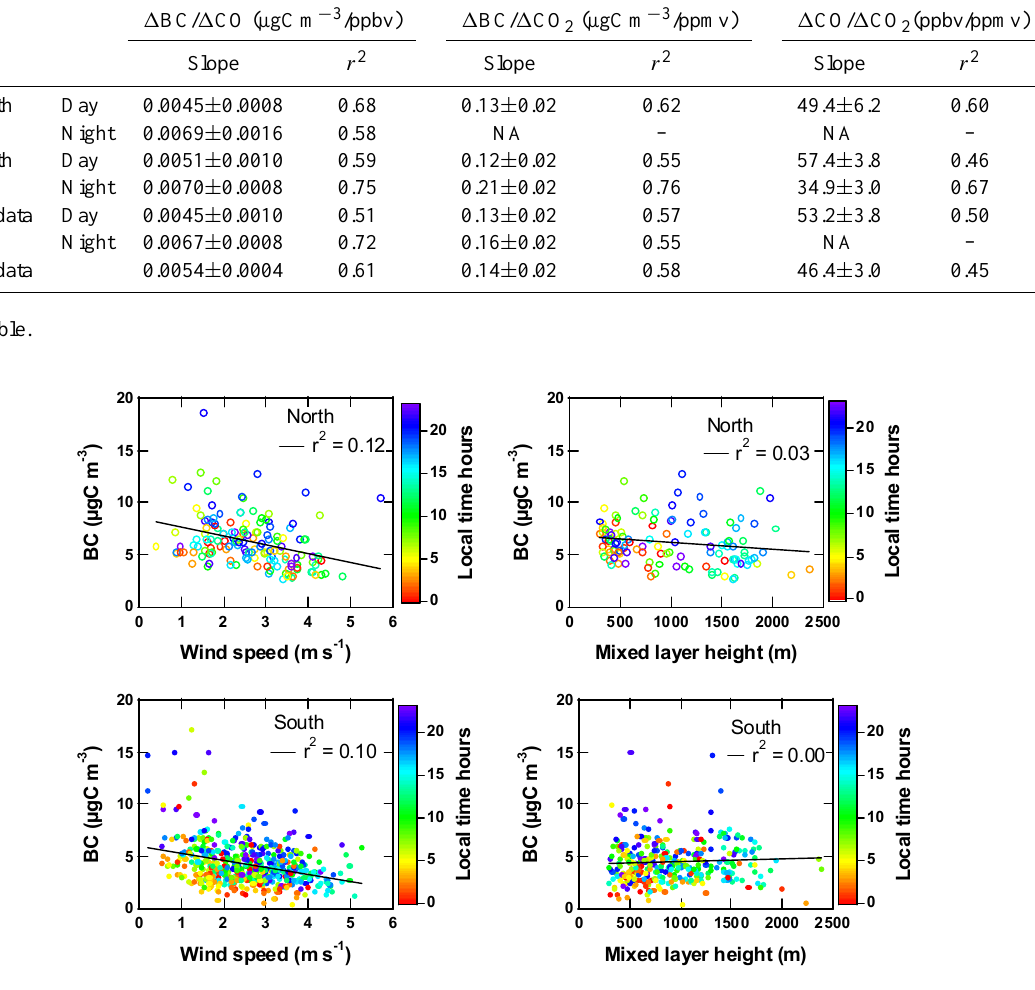
Fig. 7. Scatter plots of BC with wind speed and MLH. Northerly and southerly air masses are represented by open and closed circles, respectively. The vertical color bar represents the local time of measurements of